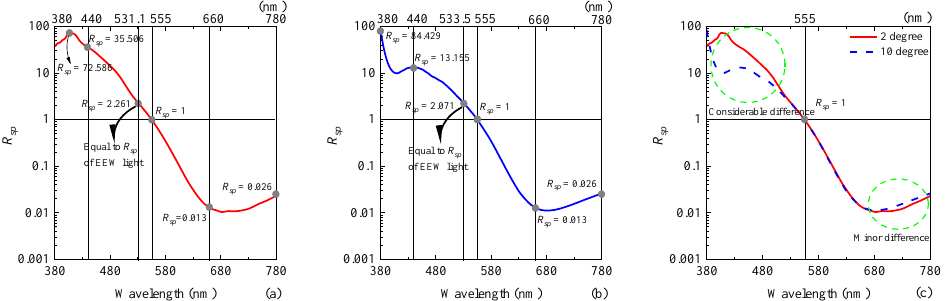
Figure 1. Spectral sensitivity curves (SSCs) for scotopic vision and photopic vision using 2- and 10-degree systems.